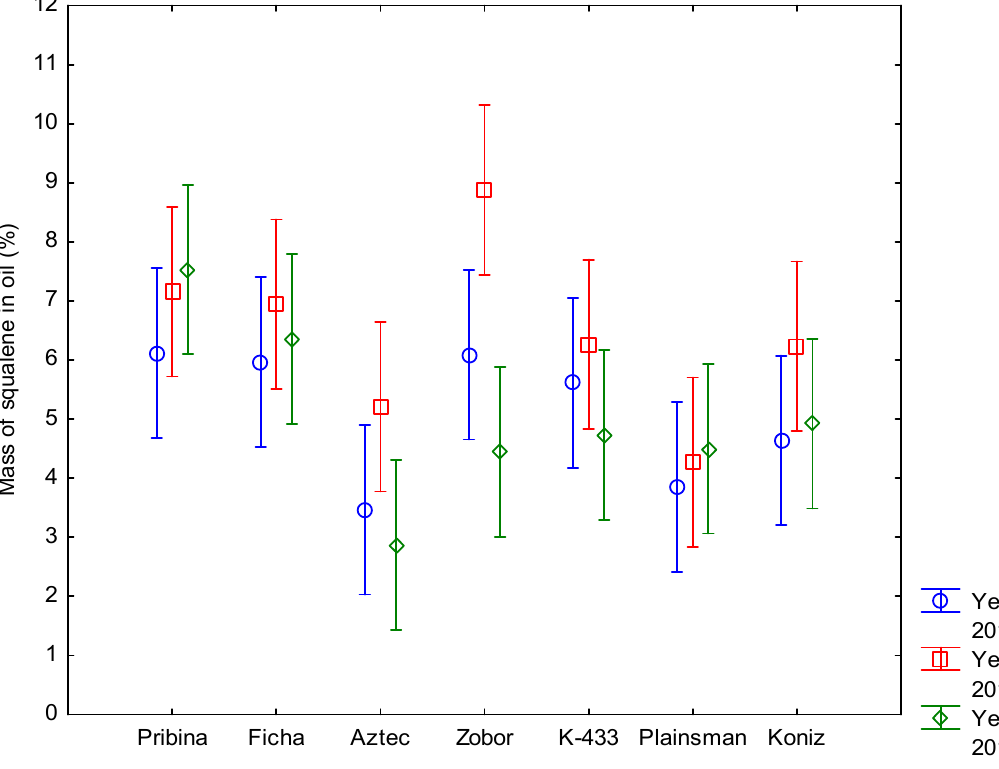
Figure 5. Comparison of consistency in content of squalene over three cropping seasons in amaranth oil. Individual columns represent 95% confidence intervals.